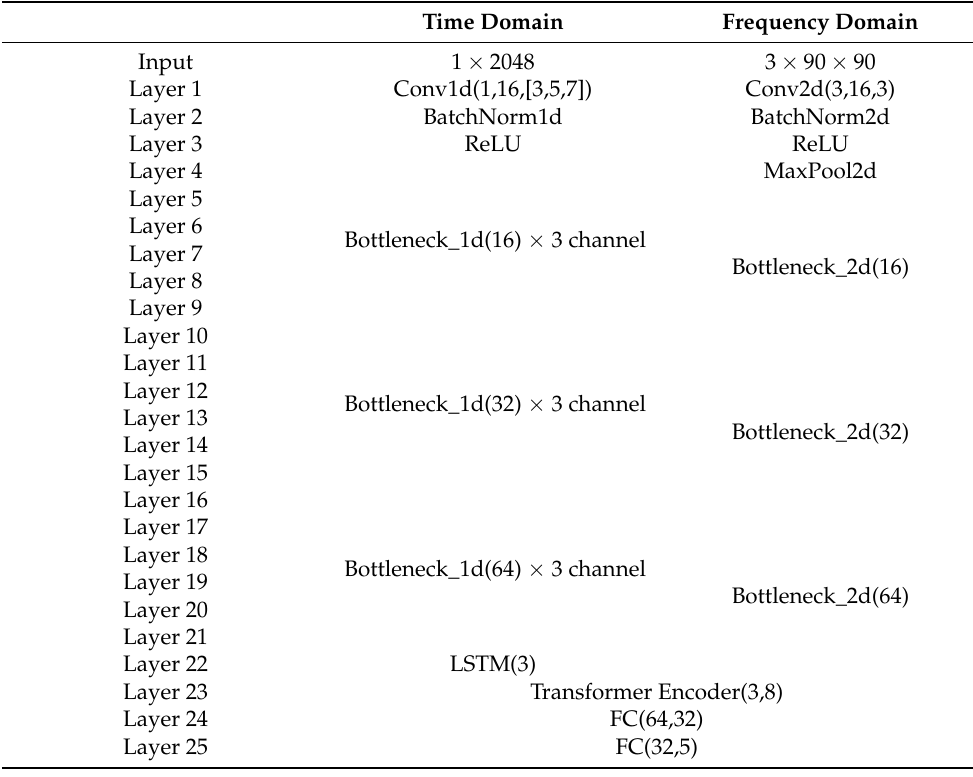
Table 2. Details of the multimodal fusion recognition